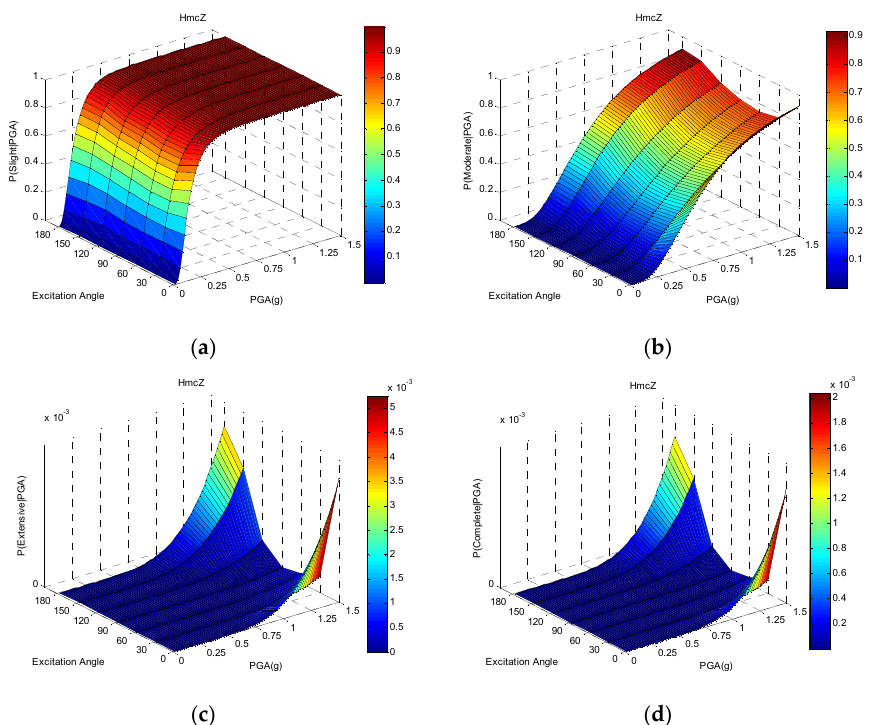
Figure A5. Seismic fragility surfaces of HmcZ subjected to different excitation angles in the ( a )slight; ( b ) moderate; ( c ) extensive; and ( d ) complete limit states.